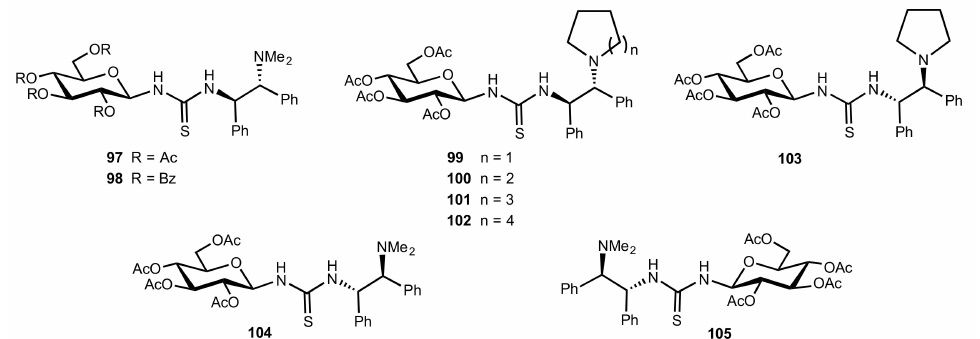
Figure 9. The structure of organocatalysts 97–105 .